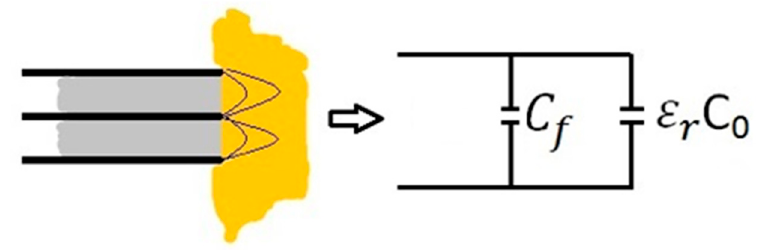
Figure 4. Capacitance model and equivalent circuit of the open-ended sensor [20].